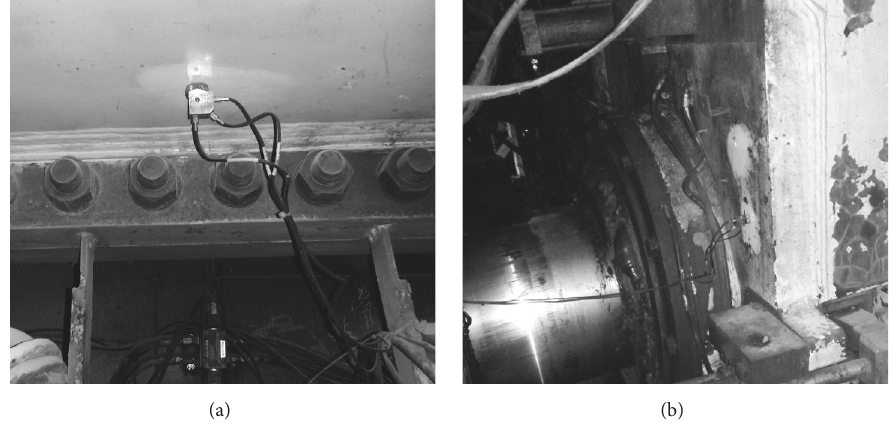
Figure 12: Measuring point at (a) main beam back tip and (b) right gripper.